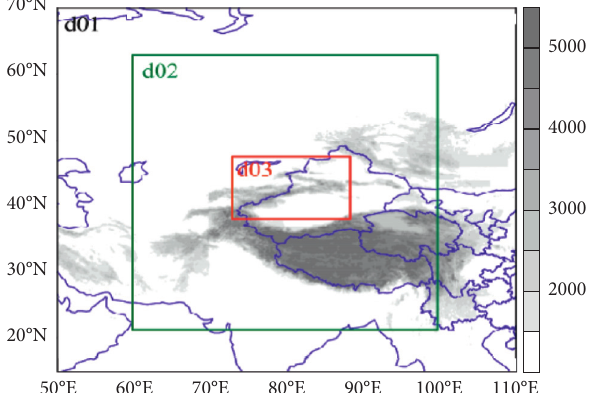
Figure 2: Model domain and terrain height (monochrome shaded, unit: m) in